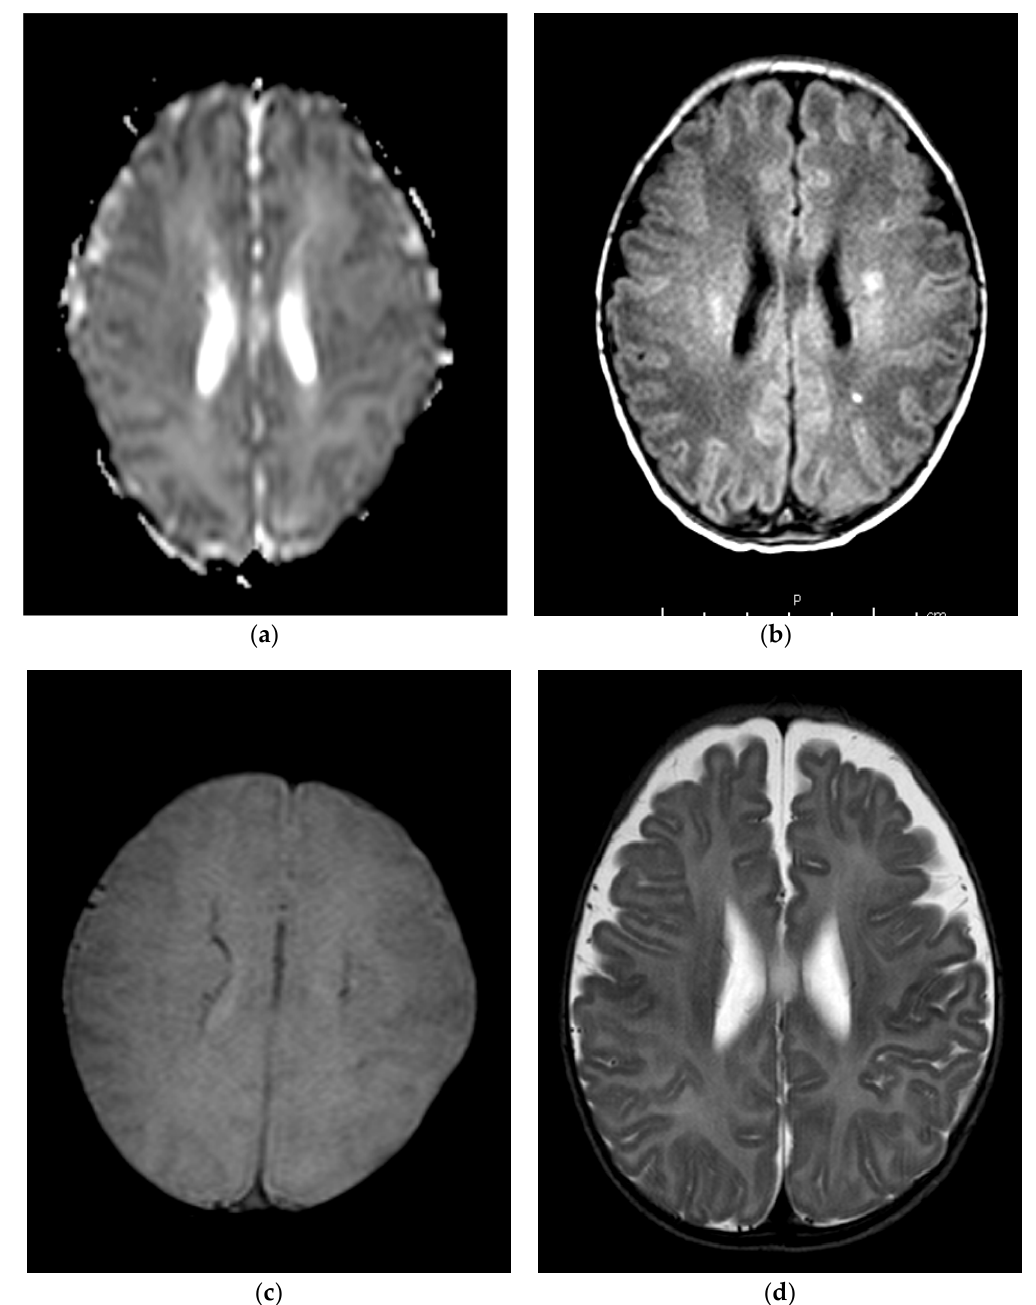
Figure 3. Brain MRI scans of case 2. ( a ) At 5 days of life, DWI showed a normal apparent diffusion coefficient of the brain. ( b , c ) At 40 days of life, T1- and T2-weighted axial spin echo sequence shows normal signal intensity of the brain.